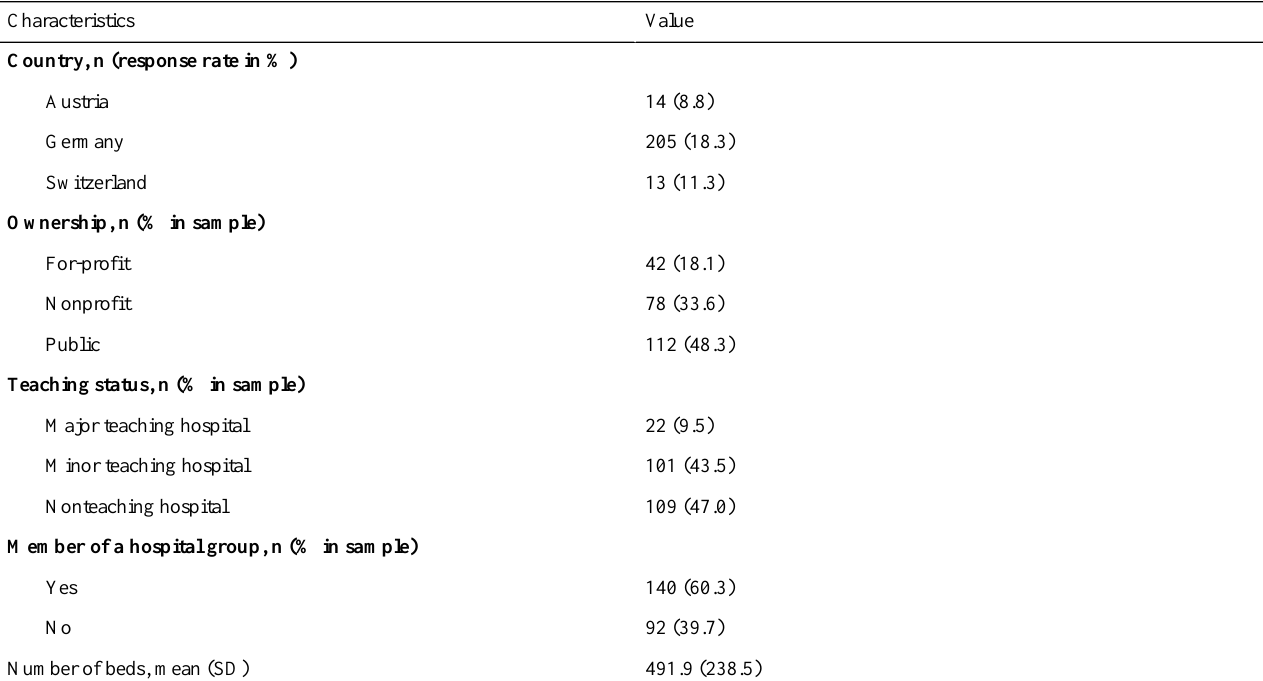
Table 3. Demographic characteristics of participating hospitals (N=232).